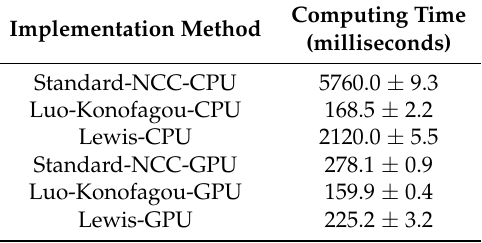
Table 1. A summary of computing time (mean ± one standard deviation) using 6 different implementations. 3D Displacement fields were first calculated for 30 slices. Then, the mean values ( ± one standard deviation) were derived and displayed below. The tracking kernel size and search region were 69 × 9 × 3 and 18 × 5 × 3,